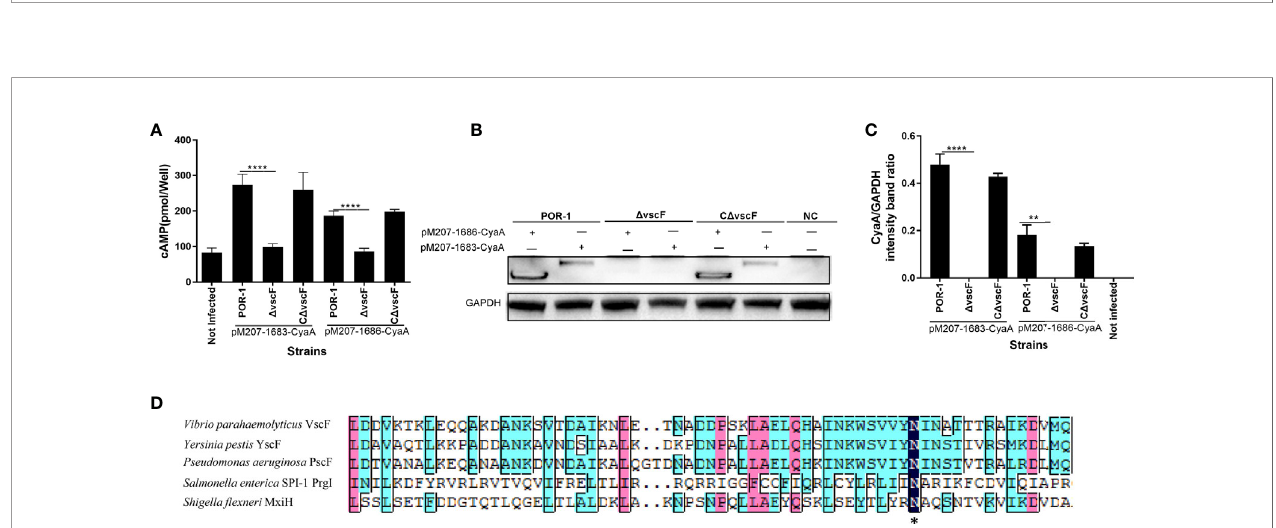
FIGURE 3 | The vscF , encoding needle protein, is diversely involved in the secretion of effector proteins in V. parahaemolyticus . Intracellular cAMP (A) and the translocated amounts of CyaA-fused protein (B) were quanti fi ed after infection with V. parahaemolyticus strains. GAPDH served as internal reference. “ + ” or “ - ” refers to a strain harboring pMMB207-vp1683/1686-CyaA expression vector (+) or not (-), NC served as cell control group. Densitometry analysis was performed for relative quanti fi cation (C) . **** P < 0.0001, ** P < 0.01, and * P < 0.05. Sequence alignments of vscF were performed using the DNAMAN program. Dark blue boxes and asterisk represents 100% conserved residues; pink boxes represent 80% conserved residues; light blue boxes represent 60% conserved residues (D)